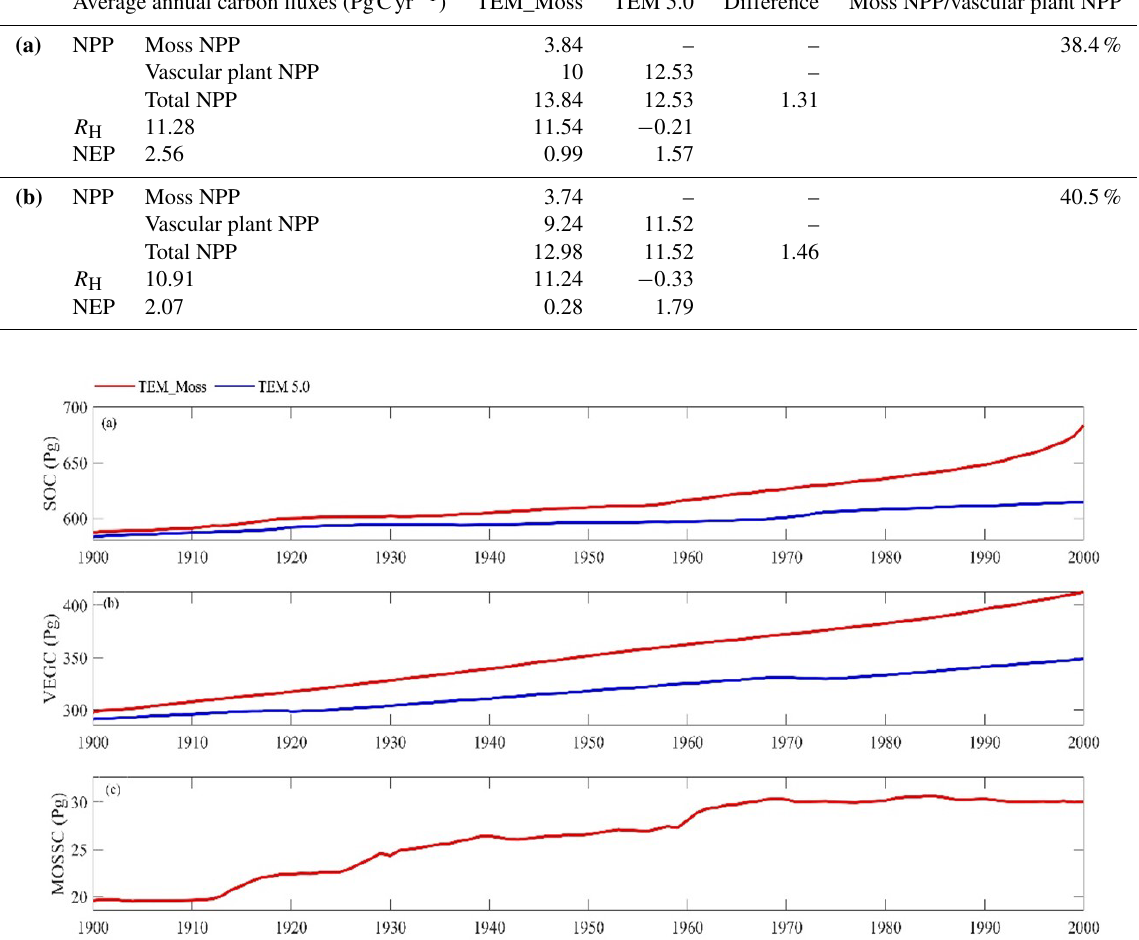
Figure 11. Simulated annual soil organic carbon (SOC, a ), vegetation carbon (VEGC, b ), and moss carbon (MOSSC, c ) during the 20th century by TEM_Moss and TEM